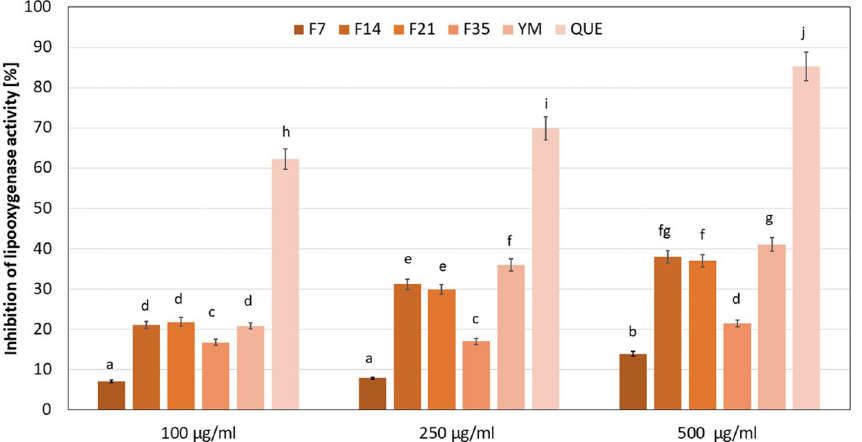
Figure 9. Anti-inflammatory effect of Yerba Mate extract and ferments. Data are the mean ± SD of three independent experiments, each of which consists of three replicates per treatment group. Different letters on the charts indicate significant differences between groups ( p < 0.05). QUE quercetin.